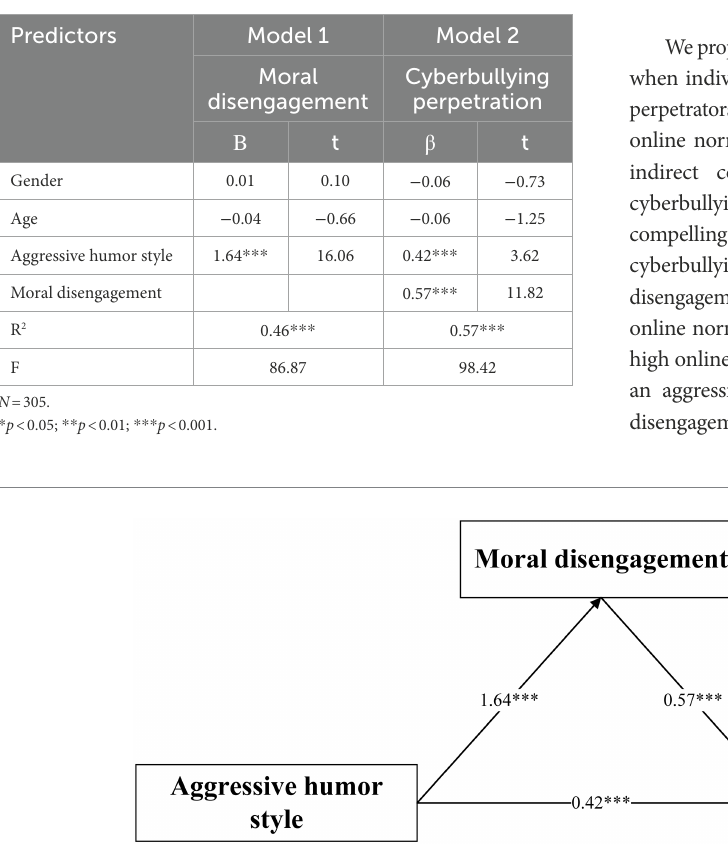
TABLE 2 Regression